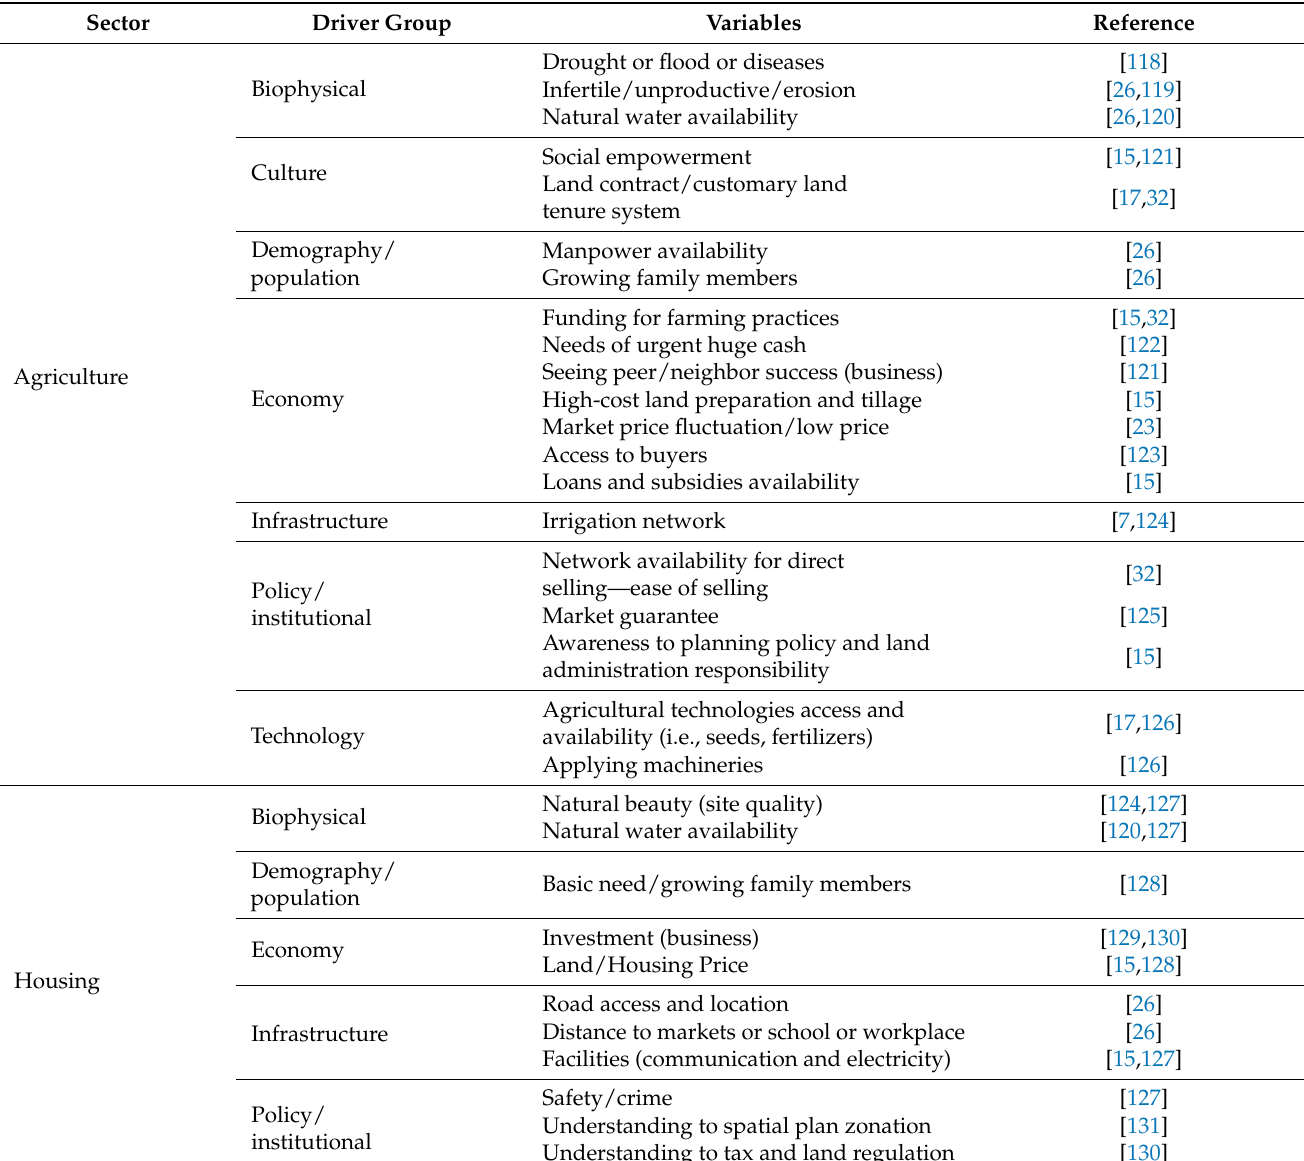
Table A1. List of Drivers Implemented in Land-Users Questionnaire.